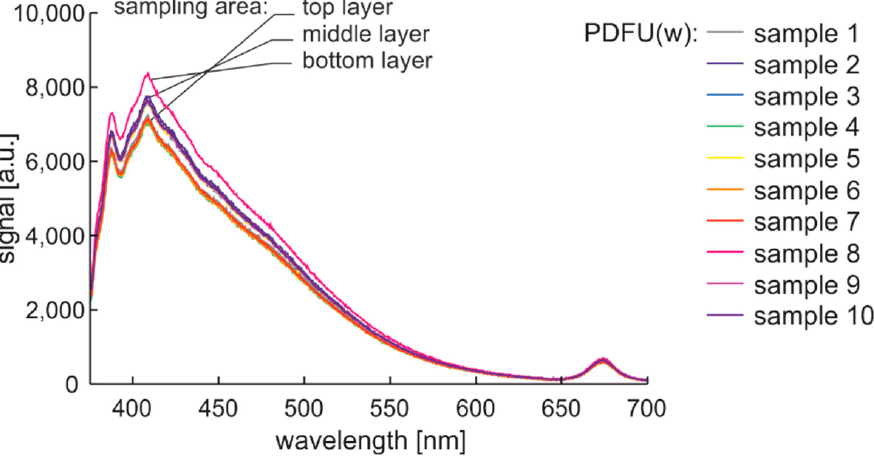
Figure 11. Fluorescence spectral data of premium diesel fuel in unmodified and winter type stored in a glass in a black box mounted on an anti-vibration base for a week. Characteristics from 380 nm to 550 nm increase with the sampling depth, which indi- cates fluorescence particle sedimentation. Interestingly, the signal of the microorganisms is not sensitive to sedimentation, which can be explained by the fact that they were alive and mobile or had a neutral buoyancy in the oil. Thus, in the following experiment, fuels are probed from the middle layers of the samples.